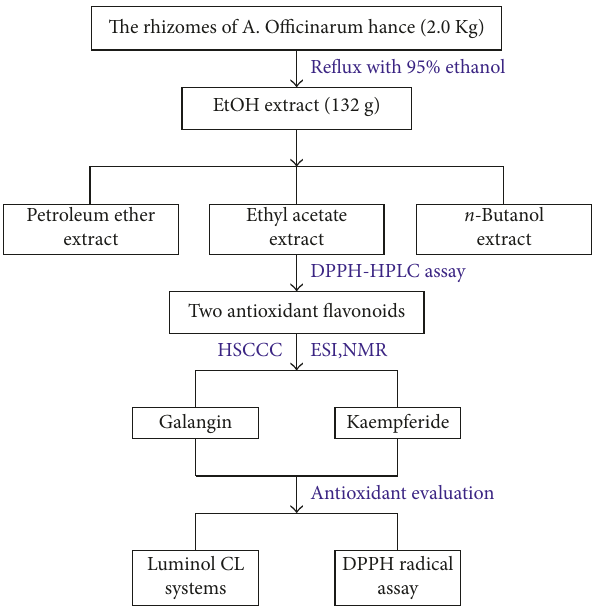
Figure 2: The procedure of screening and preparative isolation of antioxidants from A. officinarum . Table 1: Antioxidant activities of fractionations of different po- larities and target-separated antioxidants in DPPH radical assay. Samples